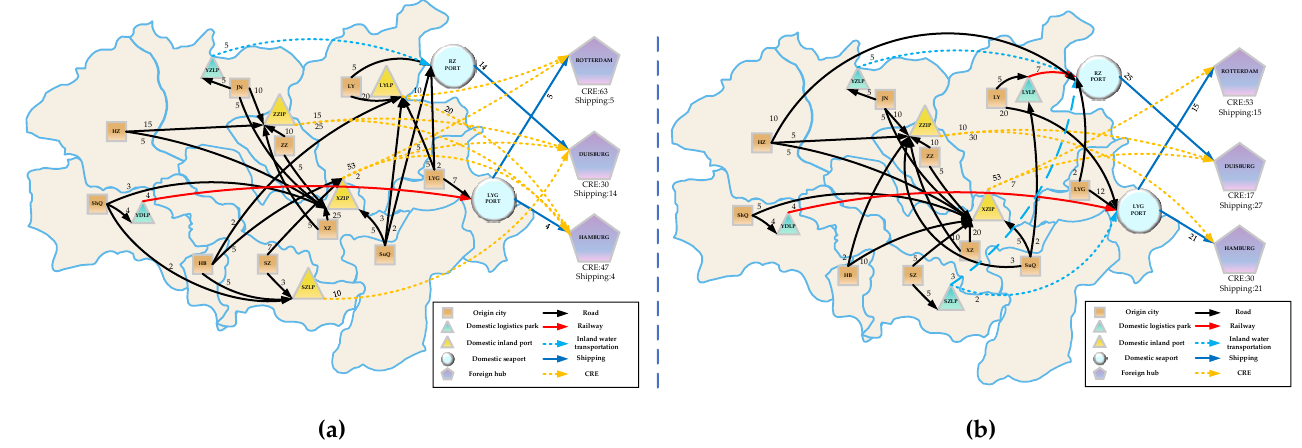
Figure 5. ( a ) Network layout when transportation cost of CRE is 2.0; ( b ) network layout when trans-